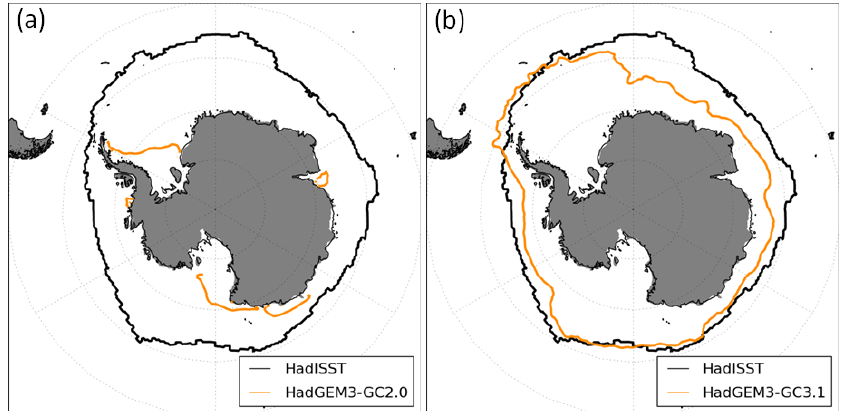
Figure 4. The Antarctic winter (June, July, and August) mean ice extent with (a) HadGEM3-GC2 and (b) HadGEM3-GC3.1 (black) com- pared with the HadISST1.2 sea ice analysis